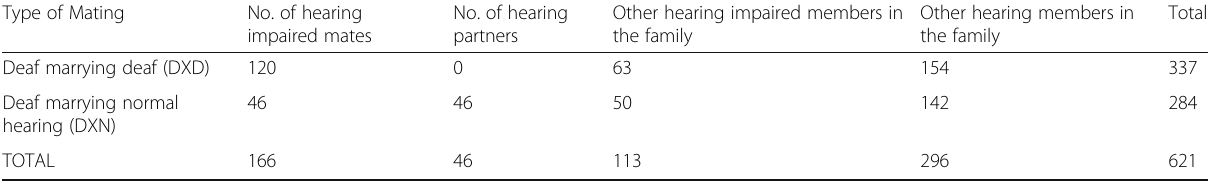
Table 1 Distribution of hearing impaired and normal hearing members in the assortative mating families Type of Mating No. of hearing No. of hearing impaired mates